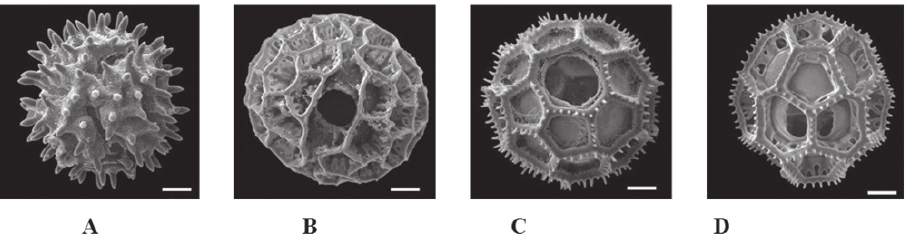
Figure 3. Representative pollen types of Vernonieae. A Echinate 3-colporate B Lophate 3- colporate C Lophate 3-porate D Lophate 6-porate (Applied from Bunwong and Chantaranothai 2008).